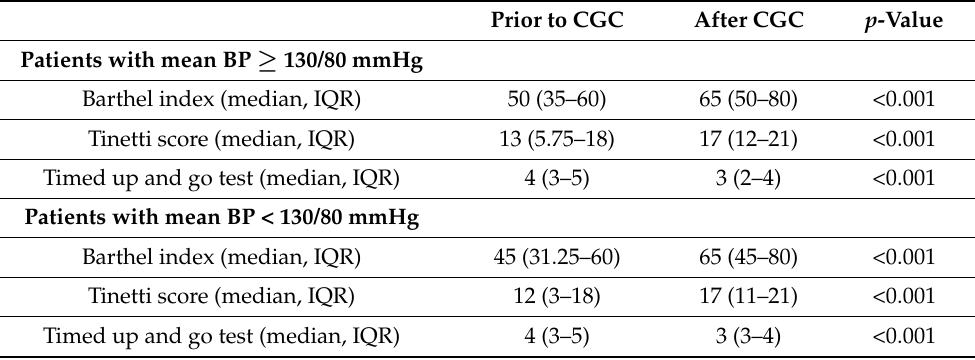
Table 2. Barthel index, Tinetti score, and timed up and go test values for geriatric patients with and without hypertensive blood pressure (BP) profiles prior to and after comprehensive geriatric care